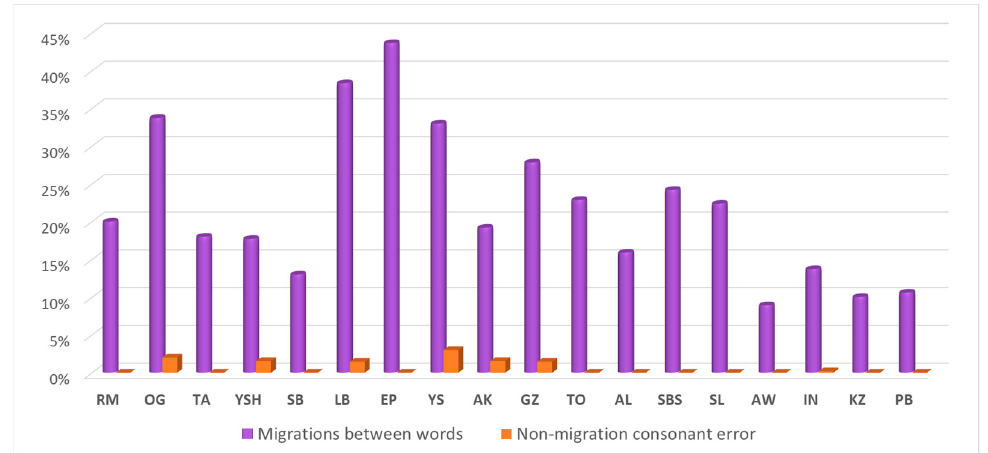
Figure 2. Percentages of consonant errors (substitution, omission, addition) that resulted from the neighboring words (migrations between words) in comparison to those that did not result from the neighboring words in all three word pair oral reading tasks.